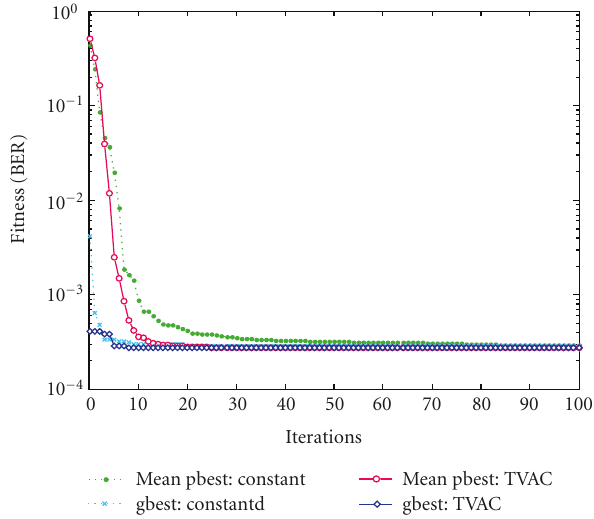
Figure 8: Di ff erent strategies of the acceleration coe ffi cients.